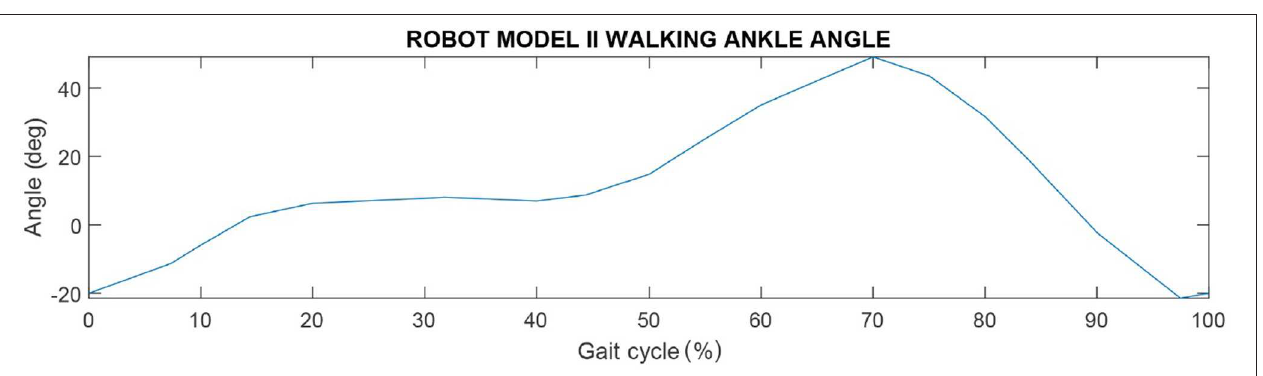
FIGURE 5 | Ankle angle input for Robot model II walking